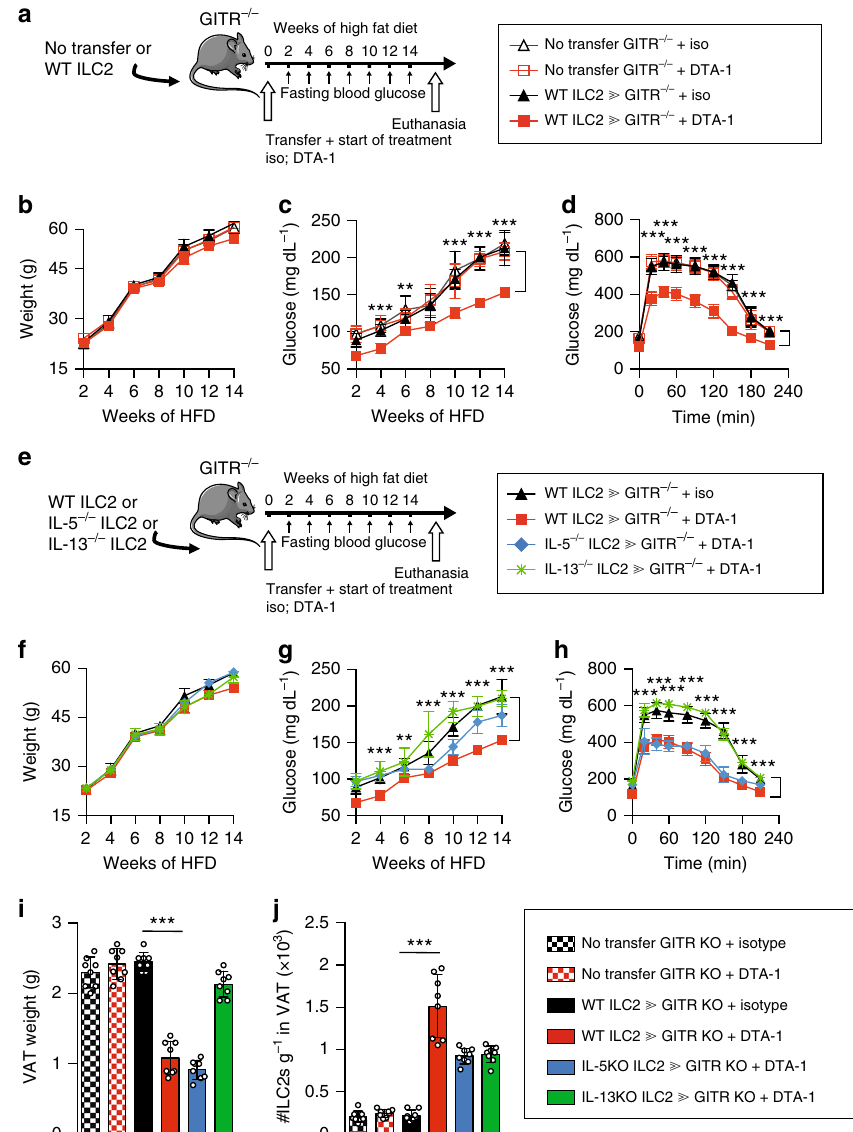
Fig. 6 GITR engagement effects are dependent on GITR on ILC2s and IL-13. a A cohort of GITR -/- mice were adoptively transferred or not with ILC2s from WT mice. After the adoptive transfer, mice were treated with DTA-1 (1 mg/mouse) or isotype control and fed on HFD for 14 weeks according to the scheme, n = 8. b Total weight and c fasting blood glucose levels were measured every two weeks for 14 weeks. d Glucose tolerance test was performed after 14 weeks of treatment. e A cohort of GITR -/- mice were adoptively transferred with ILC2s from either WT, IL-5 -/- , or IL-13 -/- mice. After the adoptive transfer, mice were treated with DTA-1 or isotype control and fed on HFD for 14 weeks according to the scheme, n = 8. f Total weight and g fasting blood glucose levels were measured every two weeks for 14 weeks. h Glucose tolerance test was performed after 14 weeks of treatment. VAT weight ( i ) was measured and number of ILC2s per gram of VAT ( j ) was quanti fi ed 14 weeks after adoptive transfer. Error bars are the mean ± SEM. Student ’ s t -test, ** p < 0.01, *** p < 0.001. Mouse image provided with permission from Servier Medical